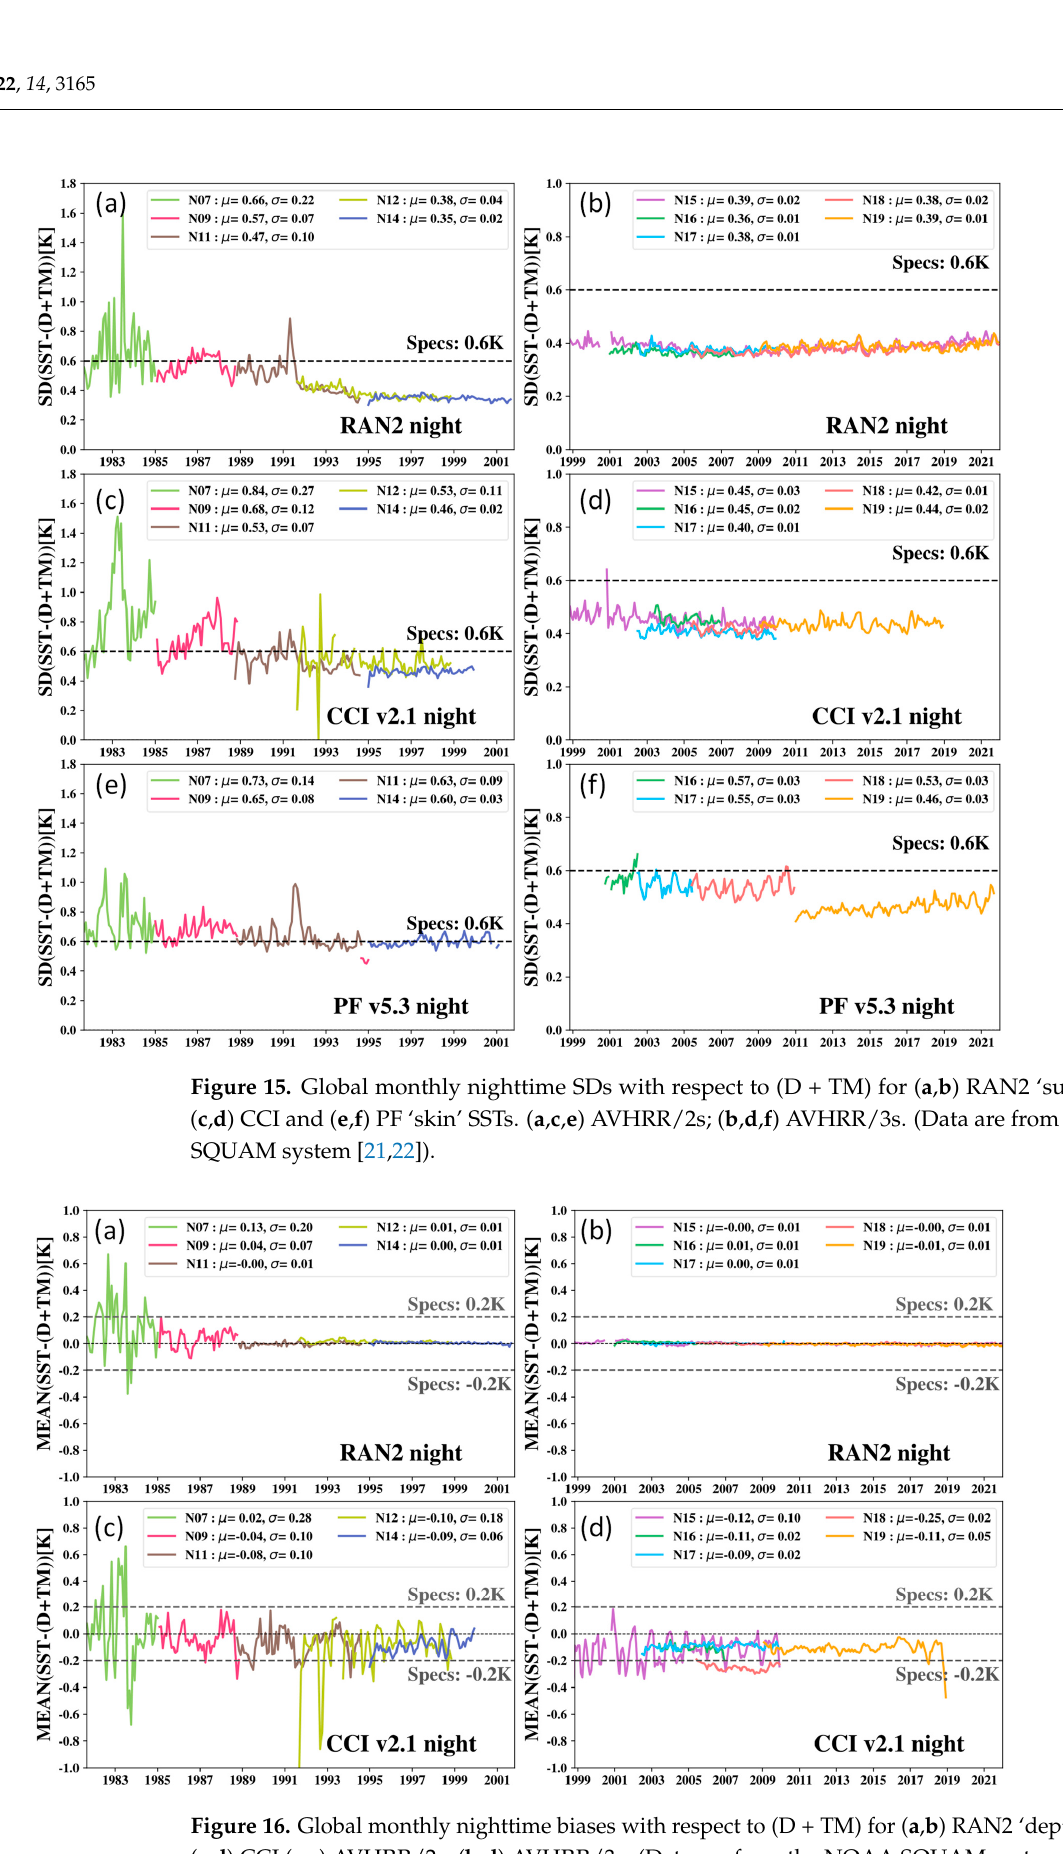
Figure 17. Global monthly nighttime SDs with respect to (D + TM) for ( a , b ) RAN2 ‘depth’ SST and ( c , d ) CCI ( a , c ) AVHRR/2s; ( b , d ) AVHRR/3s. (Data are from the NOAA SQUAM system [21,22].) 5.3. Validation of N15–N19 AVHRR/3 SSTs against AF